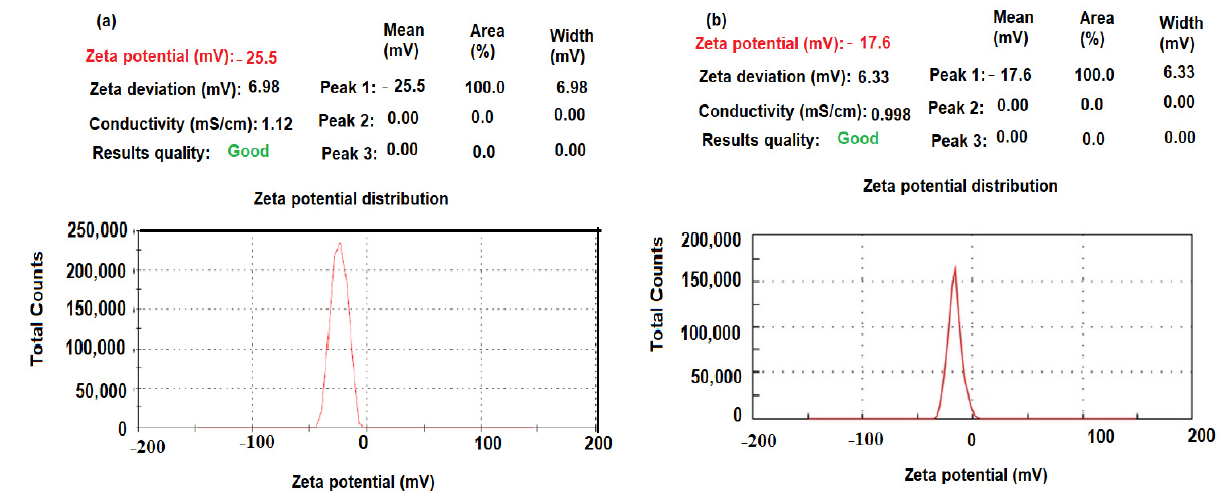
Figure 8. Zeta potential of pre-synthesized ( a ) CeO 2 NPs and ( b ) Al 2 O 3 NPs.